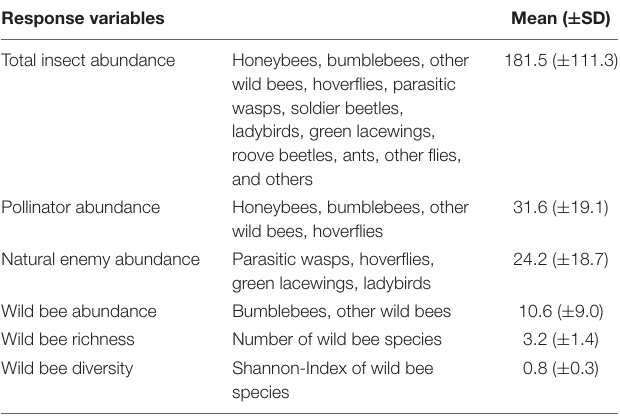
TABLE 2 | Description of abundance and diversity indicators used as response variables. Shown are means ± standard deviations per seed mixture